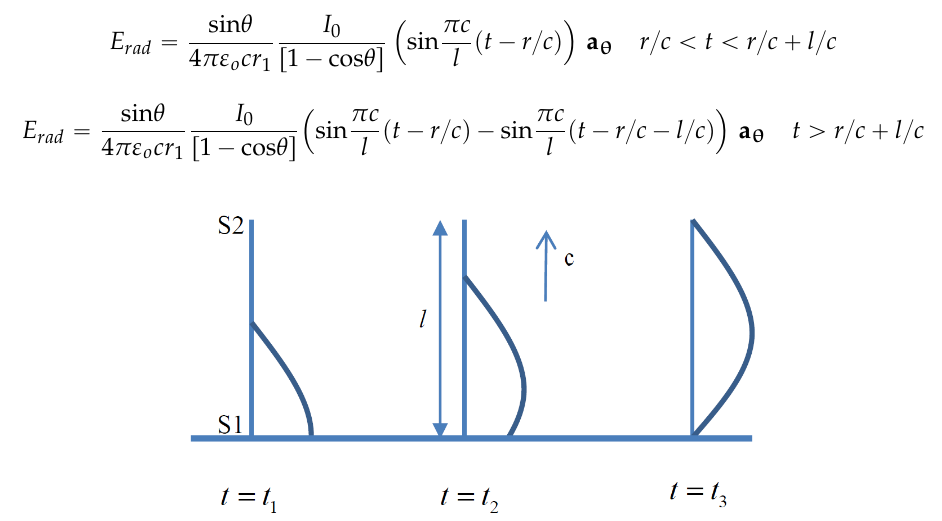
Figure 2. The figure illustrates pictorially the propagation of a current pulse in the shape of a half sine wave with a duration l / c propagating along the channel of length l with speed c . Note that t is the time and t 1 < t 2 < t 3 . Note that the duration of the current is the same as the time required for the current front to traverse the channel.